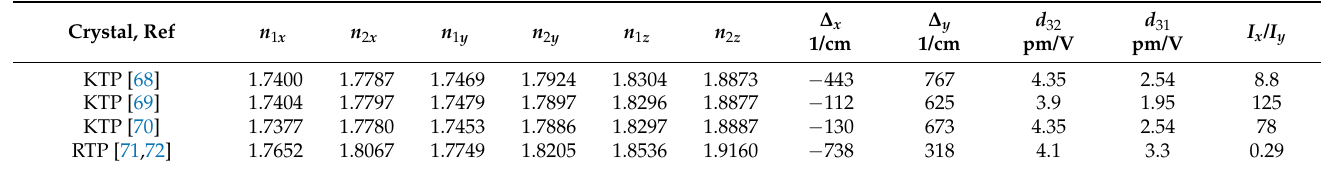
Table 1. Principle refractive indexes, phase mismatches and nonlinear coefficients affecting second harmonic efficiency in X-cut and Y-cut KTP and RTP